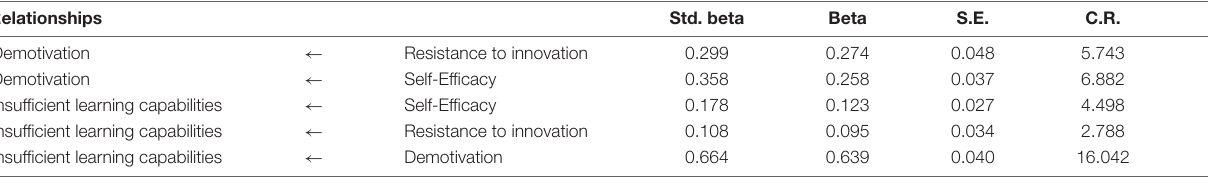
TABLE 3 | A path analysis. Relationships